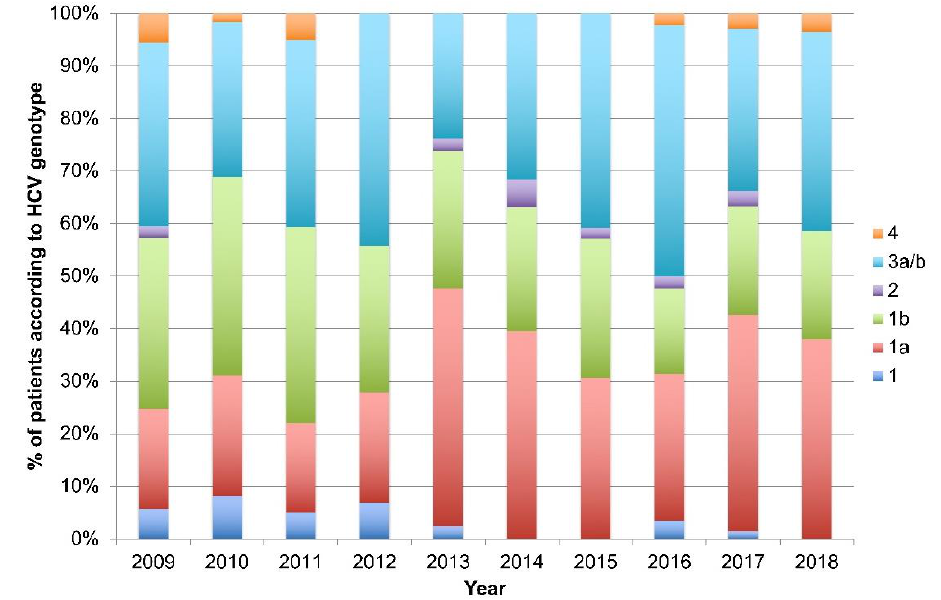
Figure 1. Genotype distribution in newly diagnosed patients with CHC.